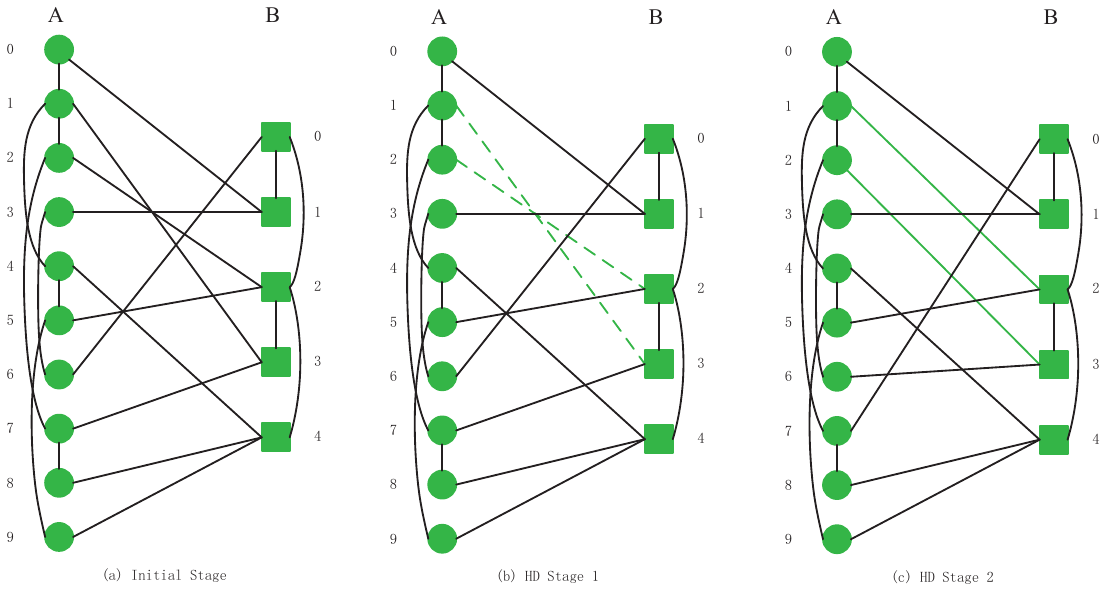
Figure 4. The full high-degree (HD) swapping inter-links strategy processes in interdependent